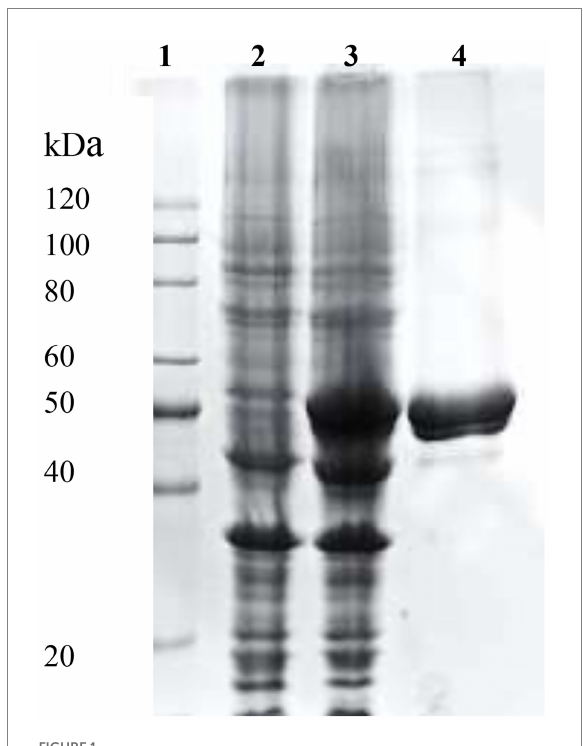
FIGURE 1 SDS-PAGE analysis of recombinant BaDyP expression and purification. Lane1, Marker; Lanes 2 and 3, Whole cell extract from Escherichia coli with an indicated expression vector without (-IPTG) and with (+IPTG) expression induction, respectively; Lane 4, Purified BaDyP eluted from Ni column with 80 mm imidazole.